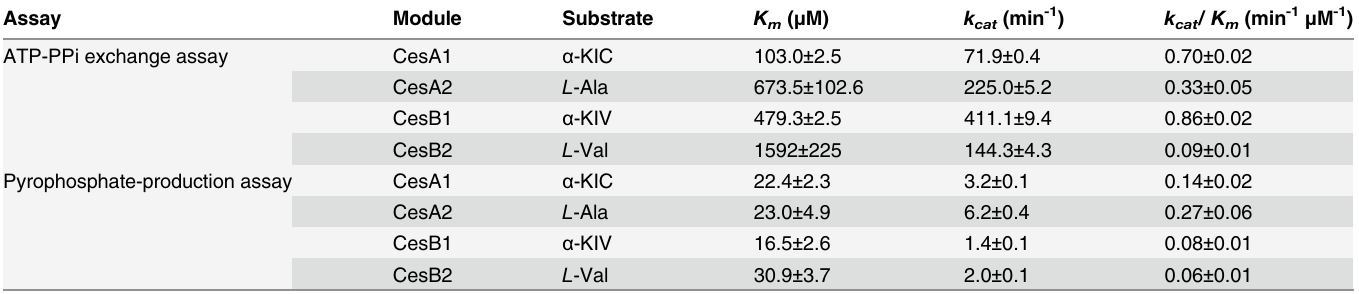
Table 1. Apparent catalytic constants of adenylation by cereulide synthetase A domains using the ATP-PPi exchange and pyrophosphate produc- tion assays. Assay